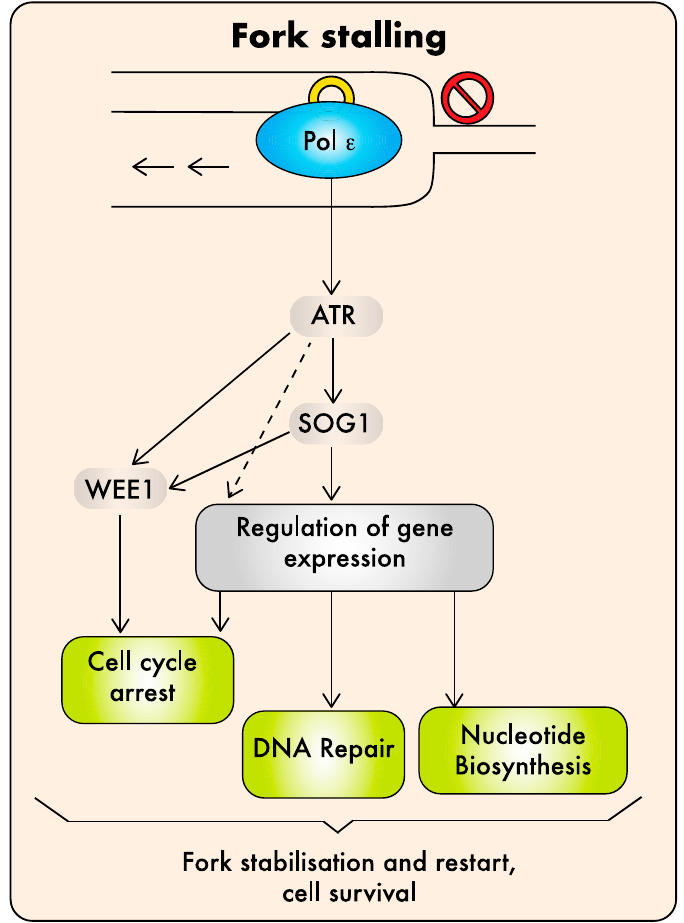
Figure 2. Model for Pol ε function in plant DNA damage repair (DDR). Pol ε may be directly involved in replicative stress sensing upstream of ATR to trigger checkpoint activation via the two SOG1-dependent and independent pathways, allowing the expression of genes involved in cell-cycle arrest, DNA repair, and nucleotide biosynthesis. In parallel, WEE1 contributes to arrest the cell cycle. The activation of all these mechanisms ultimately leads to fork stabilization and completion of DNA replication and cell survival [49,50].